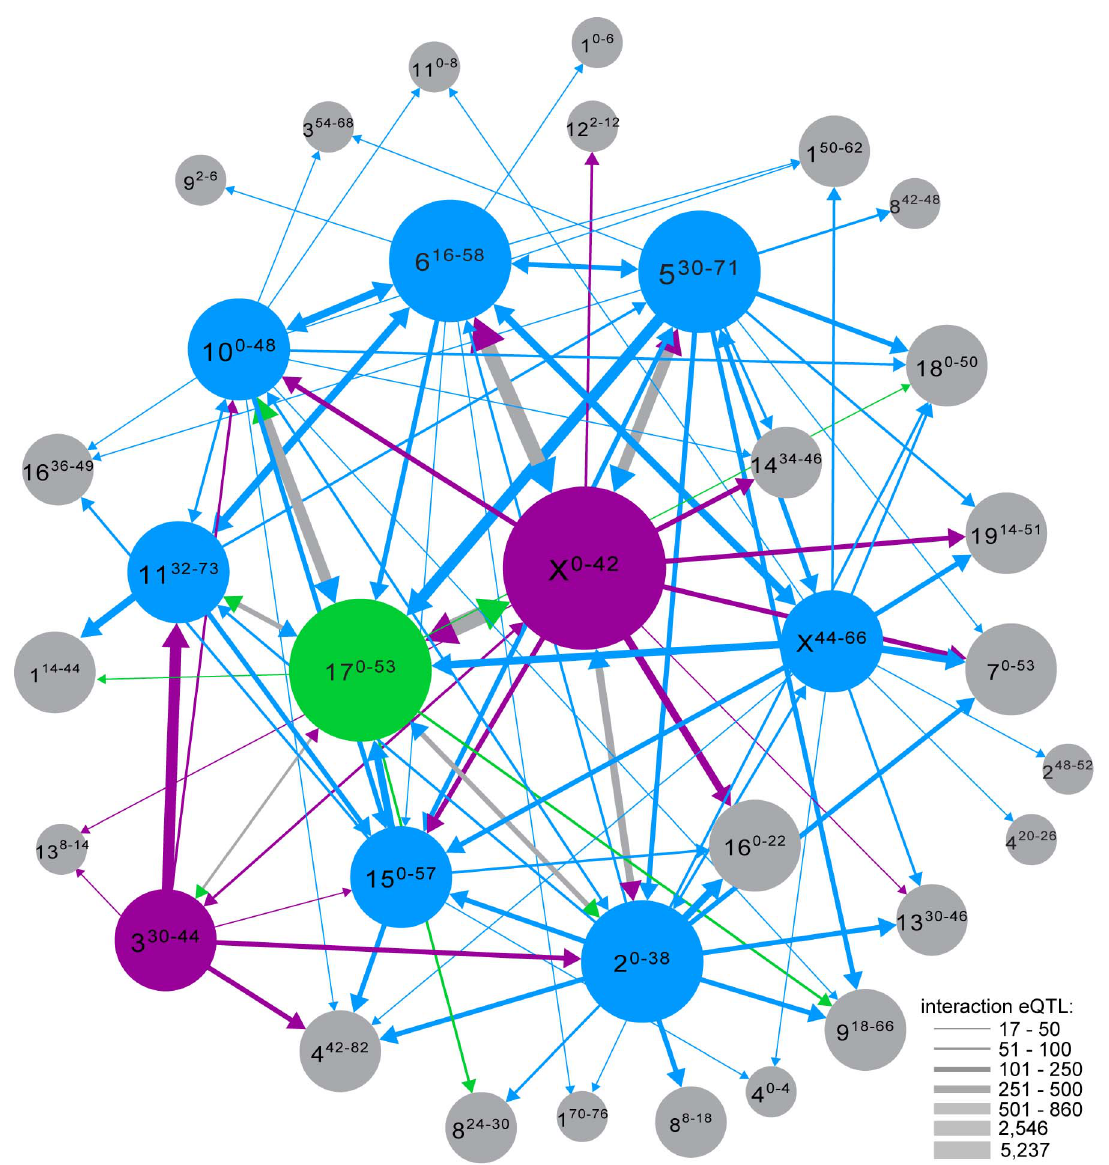
Figure 5. Interaction network. Interaction eQTL hotspots identified with different genotype covariates are shown as single nodes if the distance between regions was , 12.8 Mb (average distance between genotyping markers). Nodes are labeled with chromosome, and position (cM) in superscript. Nodes with musculus PWD sterile alleles are magenta, domesticus WSB sterile alleles in blue and sterile heterozygous genotypes in green. Edge weight indicates the number of interaction eQTL. Node size is proportional to total number of interactions. Edge color matches sterile allele at marker used as covariate and arrow points to node of peak position. Edges with two arrowheads indicate reciprocal covariate/peak interactions between nodes; if sterile alleles differ, edge is gray and arrowheads indicate sterile allele at opposite